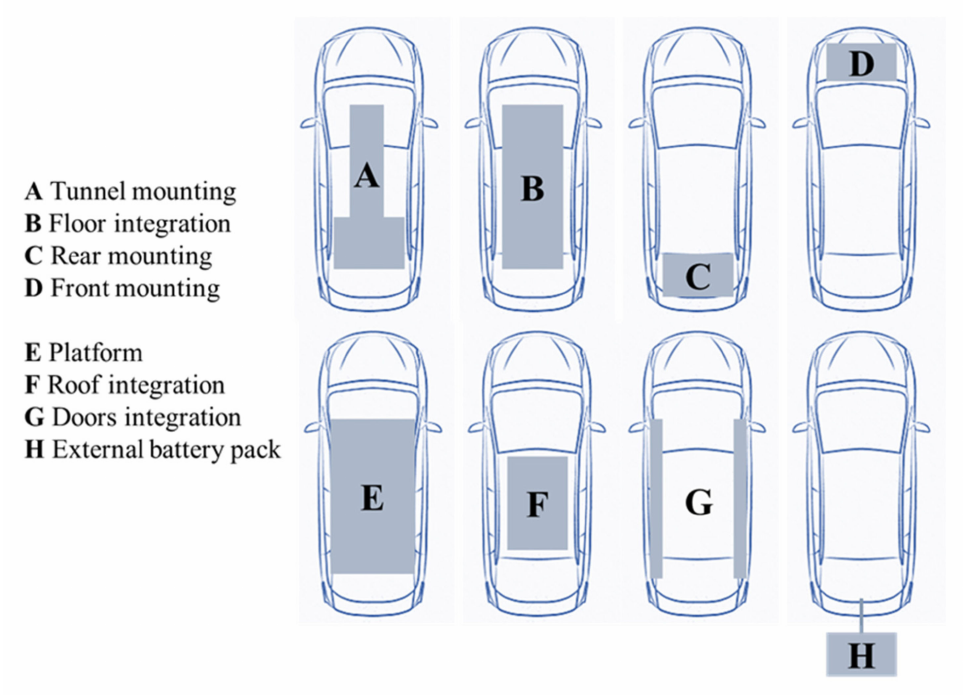
Figure 1. Installation and integration of battery pack into the vehicle: Overview of possible locations. The options ( A – D ) are based on a benchmarking of available concepts; options ( E – H ) are possible solutions to be explored, not yet used in the automotive